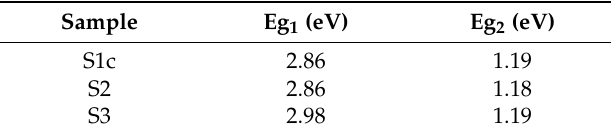
Table 1. Band gaps of investigated samples calculated from UV-Vis measurements using formula [F(R) × h υ ] 1 / 2